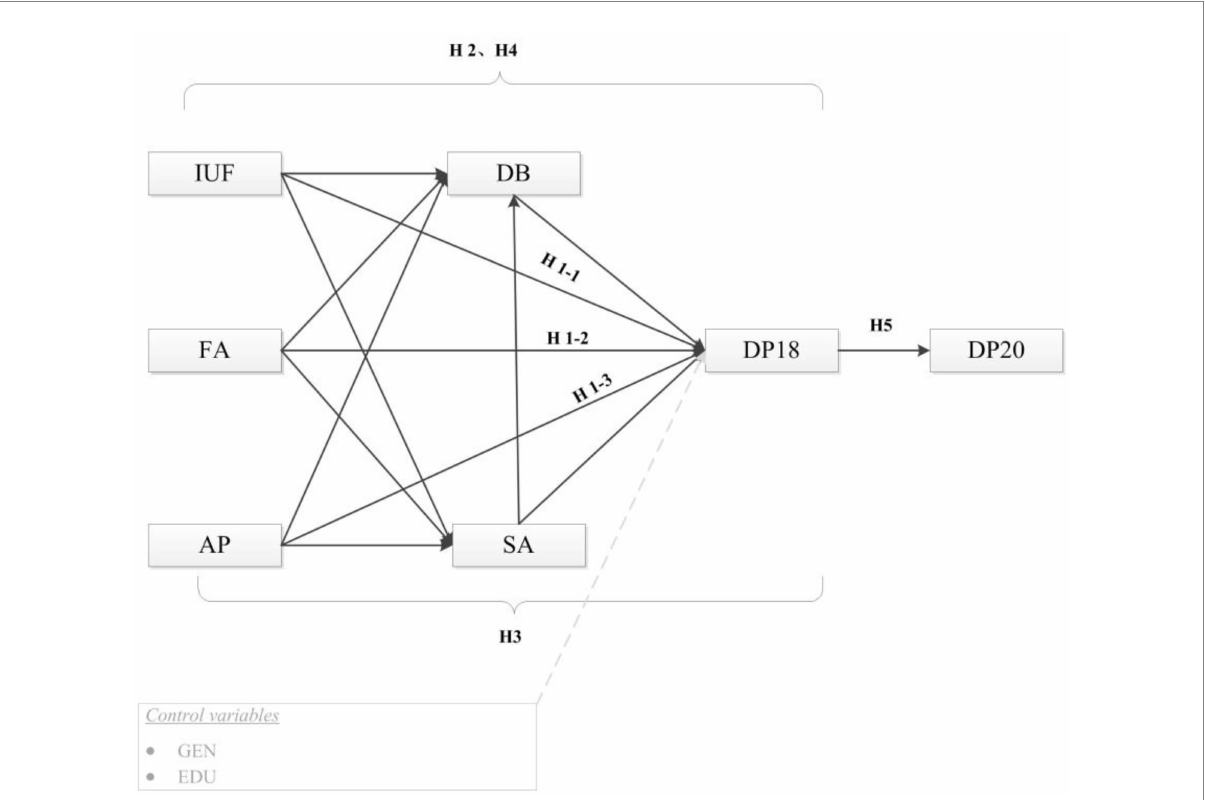
FIGURE 1 Hypothesized model of the research framework. IUF, Internet use Frequency; FA, Family Atmosphere; AP, Academic Performance; SA, Self- adjustment; DB, Deviant Behavior; DP18, Depression in 2017–2018; DP20, Depression in